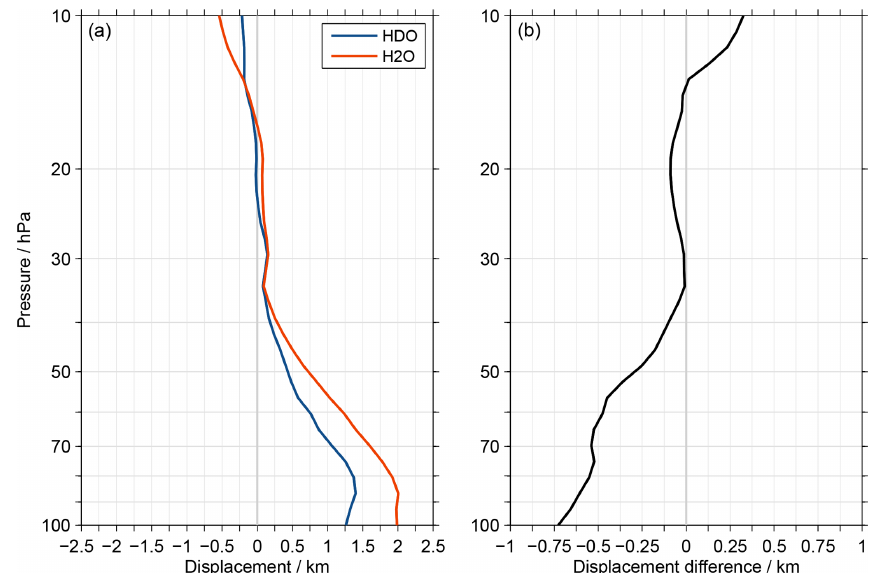
Figure 5. (a) The displacement between the MIPAS HDO and H 2 O averaging kernel peak altitudes and the corresponding retrieval altitudes. (b) The differences between the HDO and H 2 O